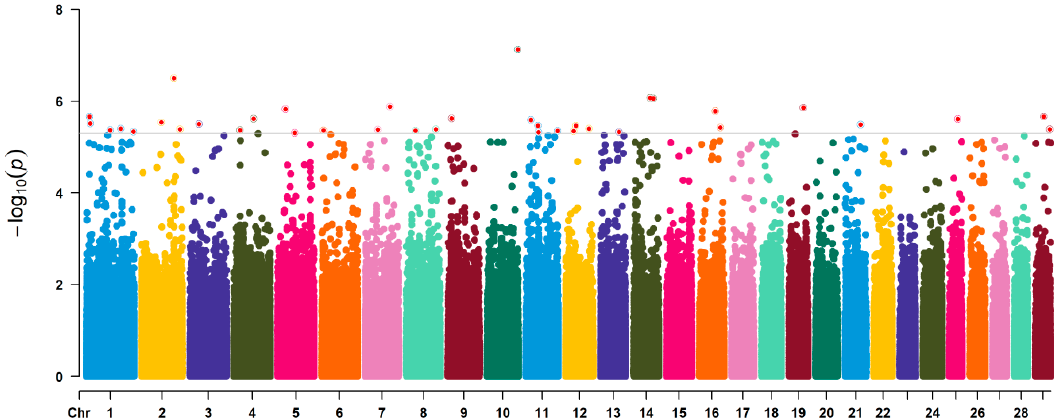
Figure 2. Quantile-quantile (Q-Q) plot of GWAS based on the random regression model. The x-axis and y-axis represent − log 10 transformed expected p -values and observed p -values, respectively. The dots indicate − log 10 ( p ) of the SNPs and the diagonal line represents the expected values under the null hypothesis for no association.